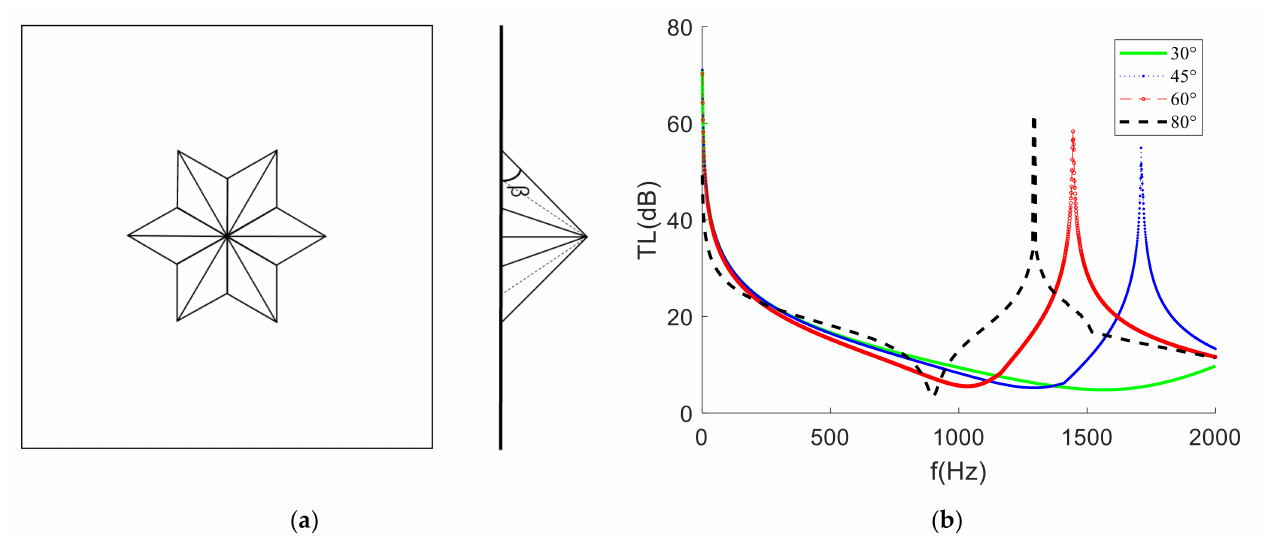
Figure 8. ( a ) The middle section of the membrane-type metamaterial. ( b ) The STL curve at different pitch angles.